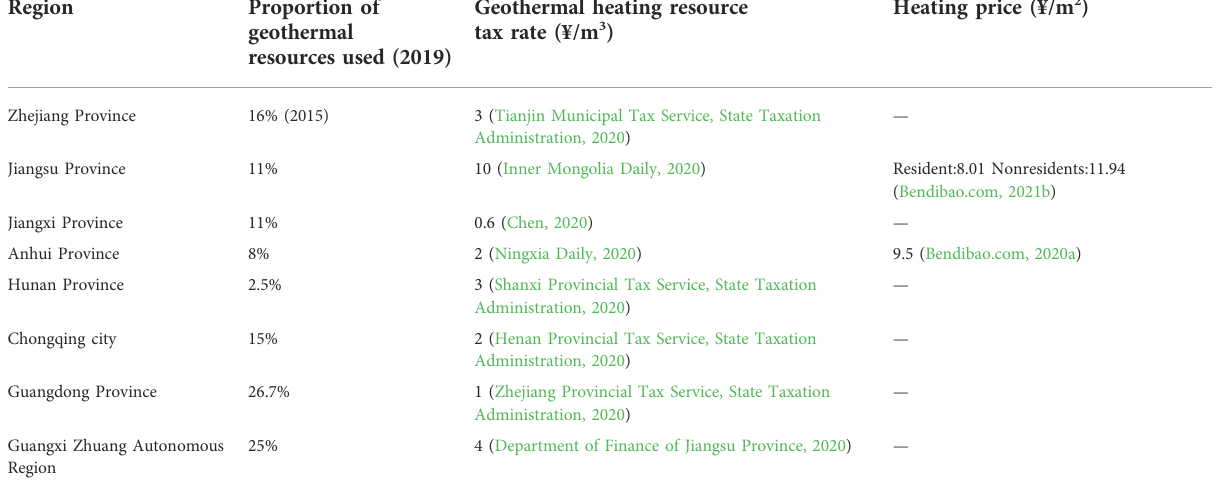
TABLE 3 Relevant input data in non-central heating areas.